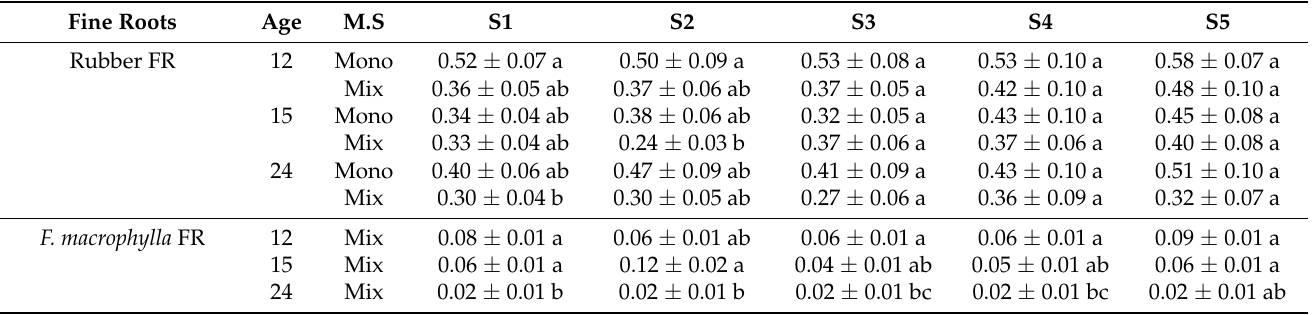
Table 2. Fine roots biomass of different species in the two-cropping systems of different seasonal